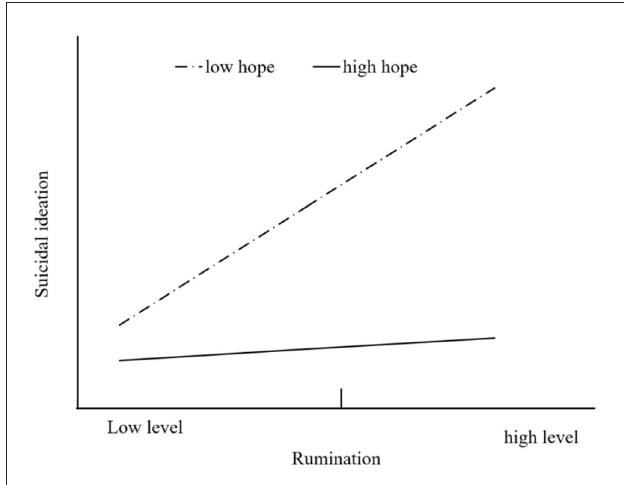
FIGURE3 Moderating effect of hope on the relationship between rumination and suicidal